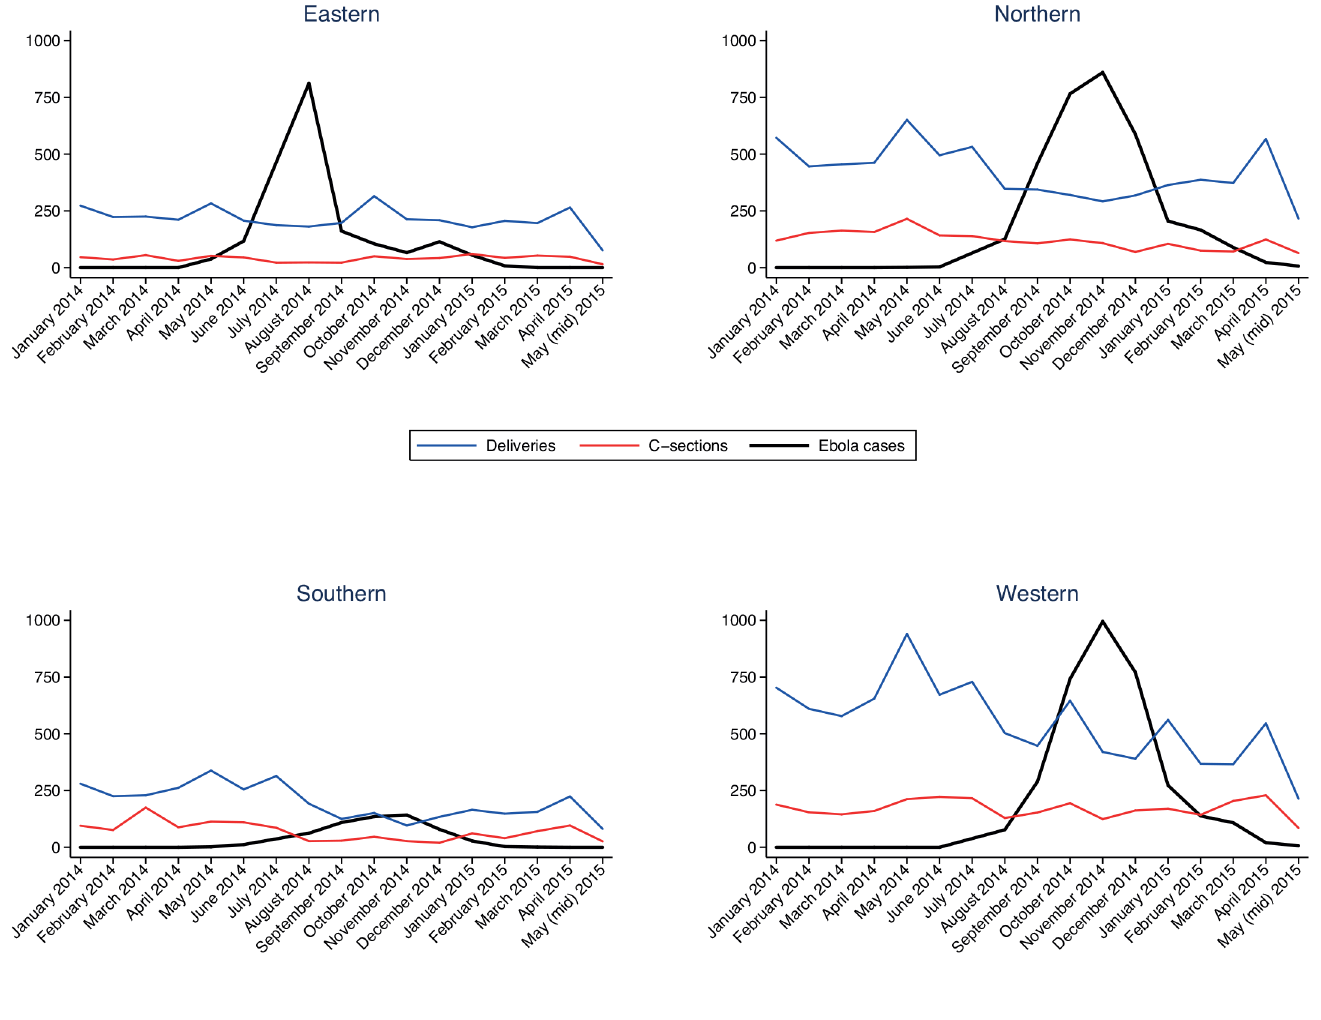
Fig 2. In-hospital deliveries and C-sections in relation to the simultaneous burden of EVD. Monthly data on number of in-hospital deliveries (blue), C- sections (red) and new EVD cases (black), shown per